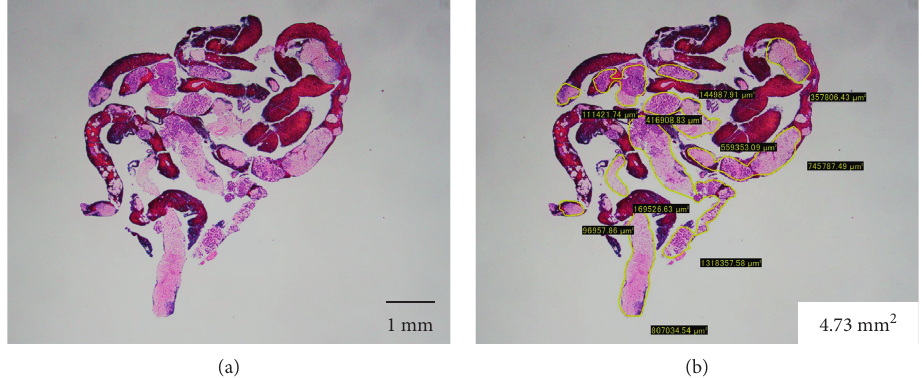
Figure 3: Evaluation of the tissue area using imaging software. (a) Hematoxylin and eosin staining of a gross specimen obtained with endoscopic ultrasound-guided fine-needle biopsy, viewed in a low-power field. (b) Measuring the area of the tissue specimen, excluding the blood clots, using imaging software